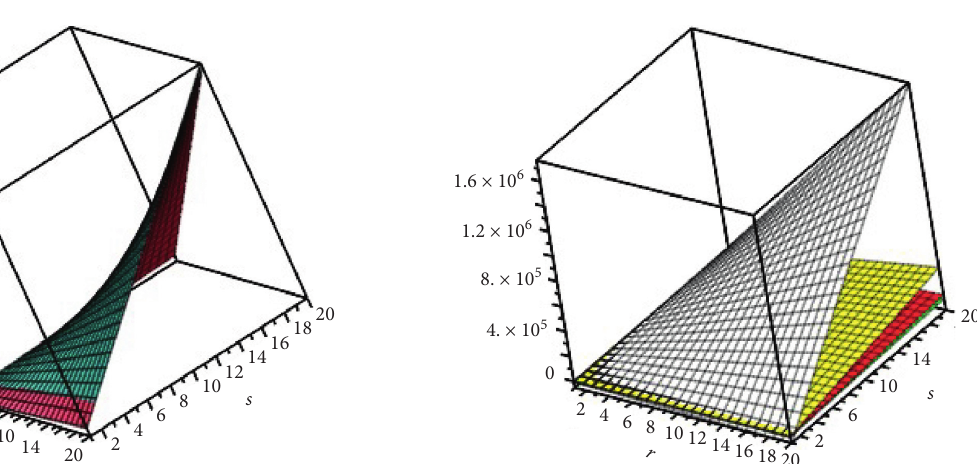
index of M [ r,s, t ] for 5